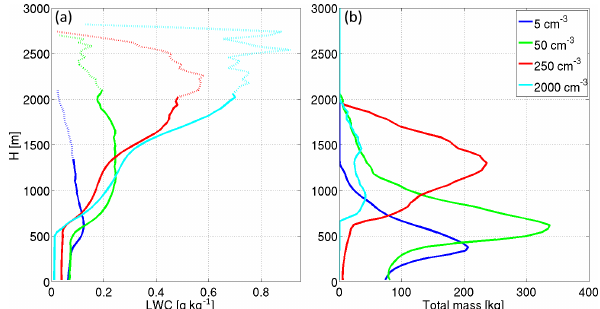
Figure 3. Mean (over time and space) of (a) updraft ( W ), (b) effec- tive terminal velocity ( η ), (c) the center of gravity velocity V COG and (d) COG (center of gravity) height as a function of the aerosol concentration. All calculated for the last 14h of the 16h of simula- tion.